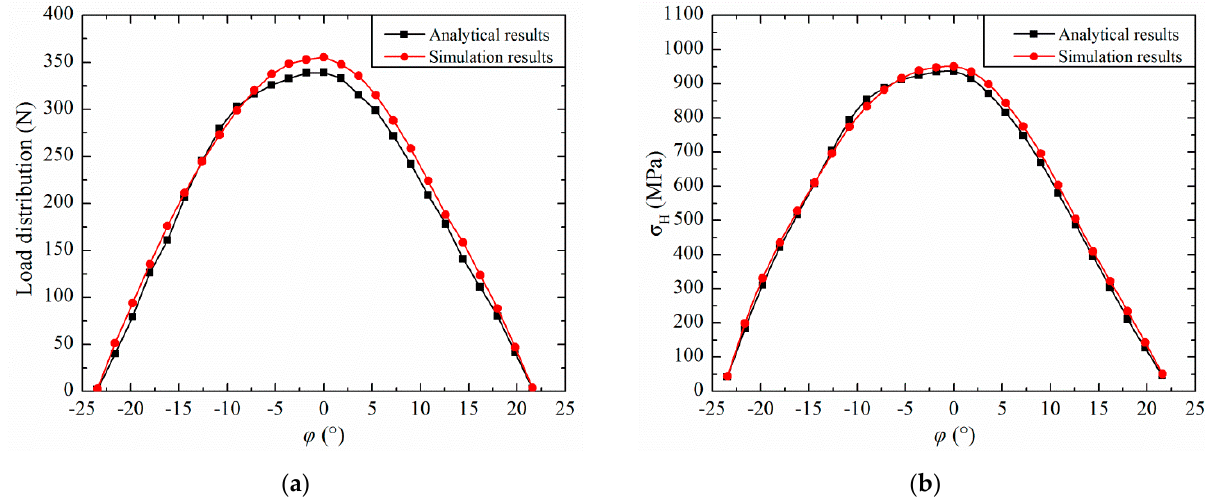
Figure 19. Results comparison of the involute disposable HD: ( a ) load distribution; ( b ) contact stress.